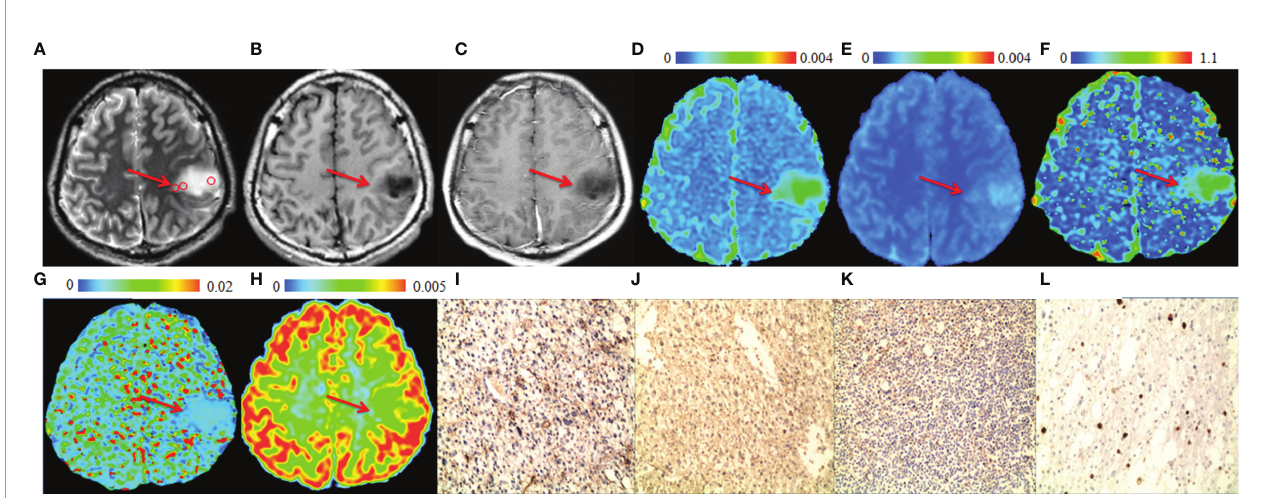
FIGURE 2 | A 28-year-old male patient with a representative astrocytoma (World Health Organization grade 2). In the tumor (arrows), (A) T2-weighted image shows hyperintense (circles are the regions of interest), (B) T1-weighted image shows hypointense. (C) Post-gadolinium T1-weighted image shows no enhancement of the tumor. (D) ADC map and (E) ADC slow map show increased values in the tumor. (F) f map shows increased values in the tumor. (G) ADC fast map show no increase in the values in the tumor. (H) ADC uh map shows no obvious increase in the value in the tumor. (I) AQP1, (J) AQP4, (K) Ki-67 and (L) AQP9 immunohistostaining maps show no obvious increase in expression (original magni fi cation,